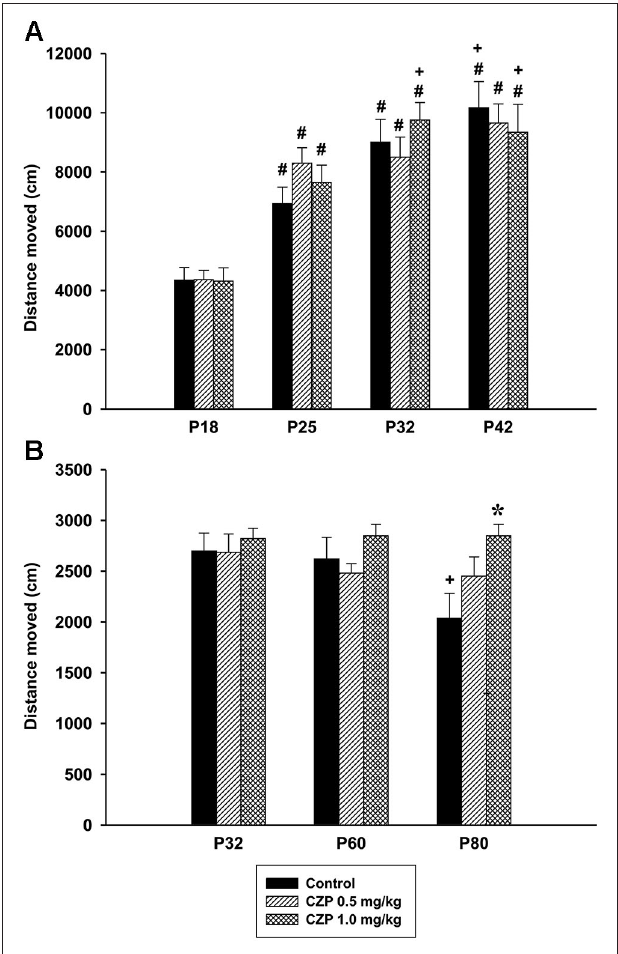
FIGURE 7 | Effect of CZP exposure (P7–P11) on locomotion . Illustrated here are the data from Experiment 2 ( social behavior during development, A ) and Experiment 3 ( social behavior in a resident-intruder paradigm, B ). # Significant difference compared to P18. + Significant difference compared to P25. * Significant difference compared to control